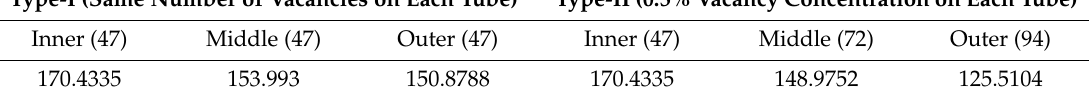
Figure 5. ( a ) Normalized PDOS curves for 3WCNTs with 47 vacancies in each tube (type-I), ( b ) Normalized PDOS curves for 3WCNTs with 0.5% vacancies in each tube (type-II). The insets show the curves for the frequency of 50–55 THz. Table 1. Values of thermal conductivity in unit of W / mK for 3WCNTs when vacancies are only positioned in one individual tube. The numbers in the parentheses are the total number of vacancies. Type-I (Same Number of Vacancies on Each Tube)